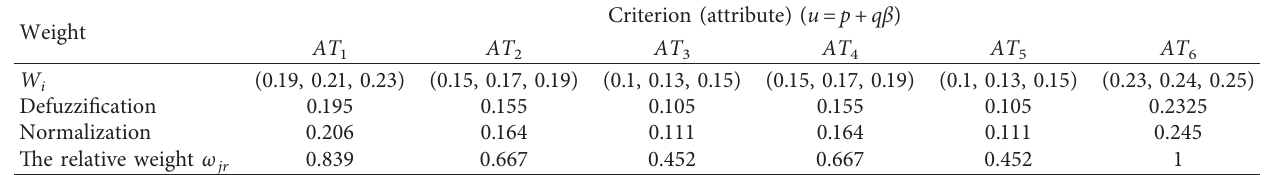
Table 4: Weight, defuzzification, normalization, and the relative weight